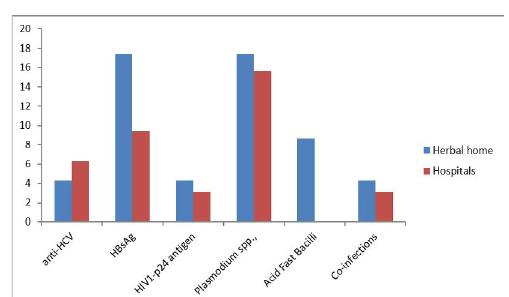
Fig. 2 . Frequency of anti-HCV, HBsAg, HIV1-p24 antigen, Acid Fast Bacilli and Plasmodium spp., in hospital